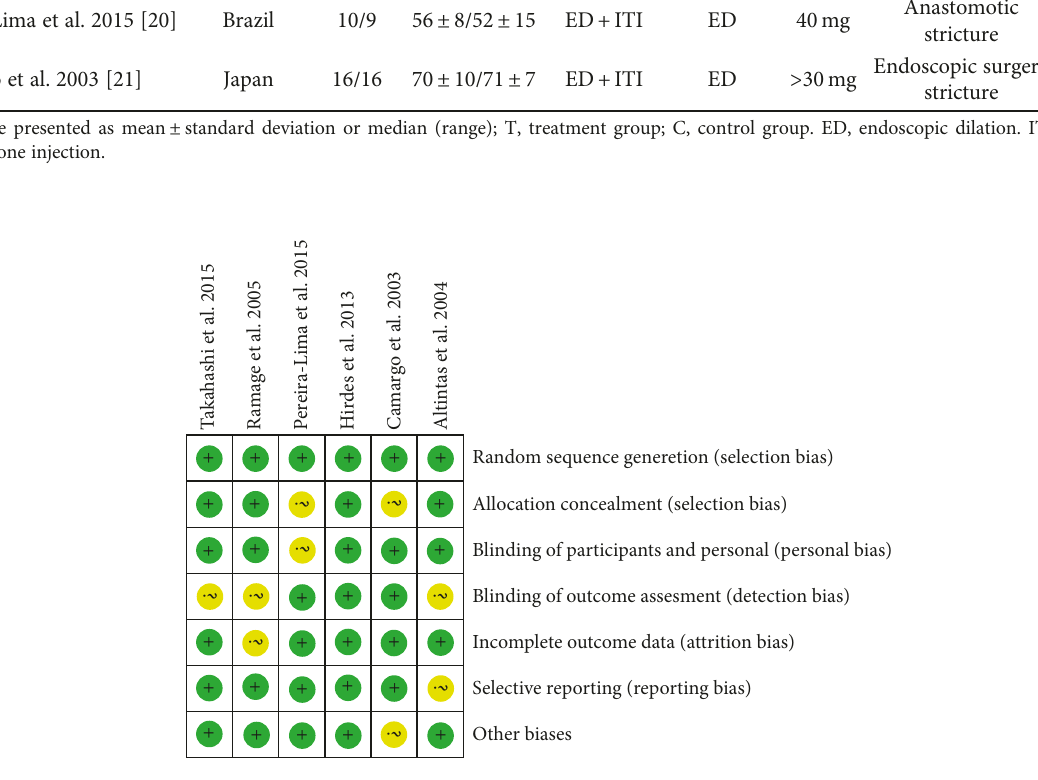
Figure 2: Summary of methodological quality of included